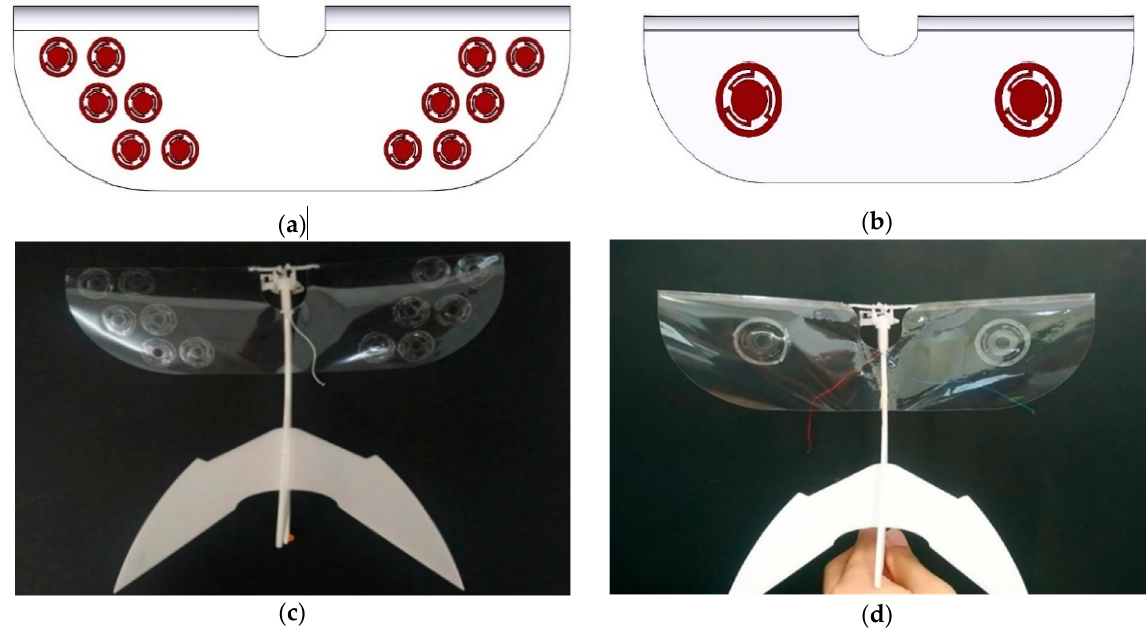
Figure 4. FWMAVs with PET wings made by a cutting plotter Graphtec CE5000-60: ( a ) 12 check-valve drawing; ( b ) 2 check-valve drawing; ( c ) multiple (×12) check-valves with disc-cap radius of 4.95 mm; ( d ) single-pair of check-valves with disc-cap radius of 7.43 mm on a wing.